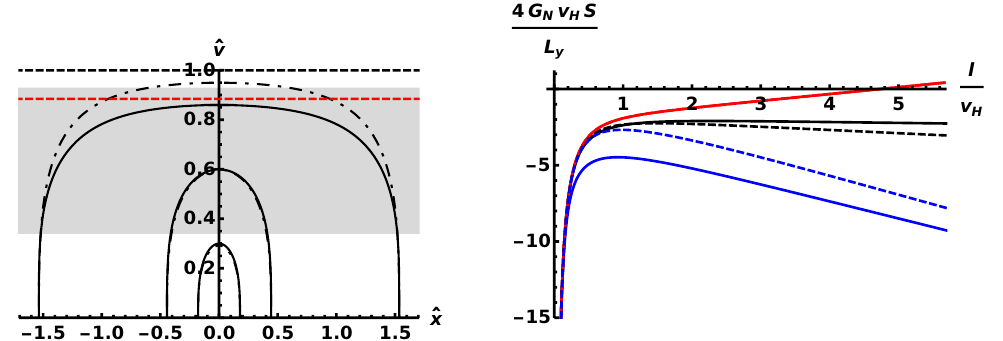
Figure 6 . Left : minimal surfaces for a few boundary strips. The solid curves correspond to surfaces which minimize the generalized functional (4.5) while the dash-dotted curves represent RT surfaces of the same boundary strips. It can be seen that the generalized functional is repelled towards the boundary when compared to the corresponding RT surface, but this effect is visible only when the surface penetrates substantially into the cloud (shaded region). The horizontal dashed lines represent the black hole horizon (black) and the edge of the shadow region (red). For this figure we have set T/µ = 0 . 02 . Right : the value of the (regularized) generalized functional as a function of strip width. The different curves correspond to T/µ = 0 . 0005 (blue), T/µ = 0 . 02 (black), and T/µ = 0 . 057 (red). We see that strips with small lengths behave similarly for different T/µ but the long range slope is affected according to the formula (4.11). For comparison, we also show the results for the generalized functional with the same values of T/µ in the pure RN case (dashed